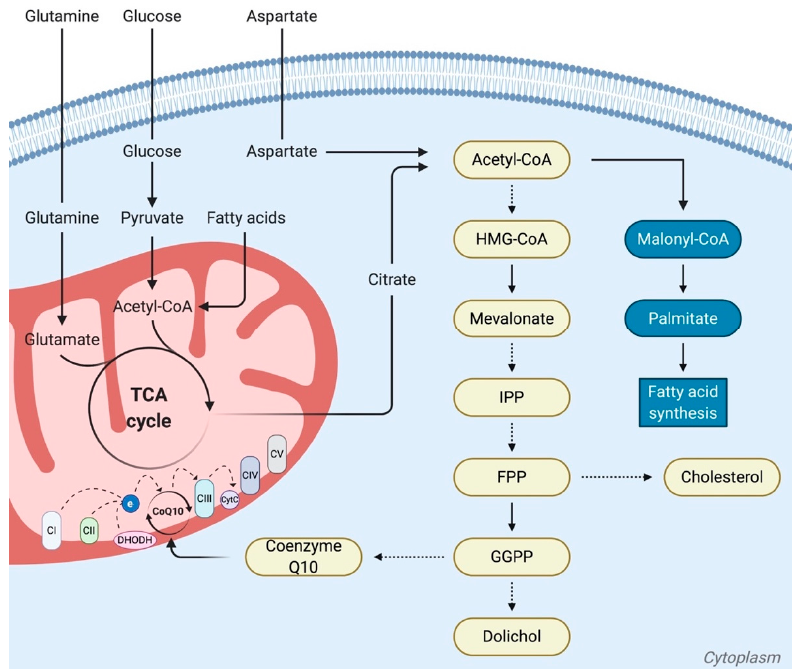
Figure 4. The mevalonate and the fatty acid synthesis pathways. Acetyl-CoA, derived from glucose, glutamine, or citrate following its export to the cytosol, is converted through the mevalonate pathway into several metabolites including cholesterol and coenzyme Q10. Coenzyme Q10 transfers electrons from complexes I and II of the electron transport chain, as well as from dihydroorotate dehydrogenase (DHODH), to complex III. Acetyl-coA also acts a precursor for fatty acid synthesis, through its conversion to malonyl-CoA, and then to palmitate. The mevalonate pathway is represented in yellow boxes. The fatty acid synthesis pathway is represented in blue boxes. Dashed arrows represent multiple steps. HMG-CoA, 3-hydroxy-3-methylglutaryl CoA; IPP, isopentenyl-diphosphate; FPP, farnesyl diphosphate; GGPP, geranylgeranyl-diphosphate; TCA cycle, tricarboxylic acid cycle.